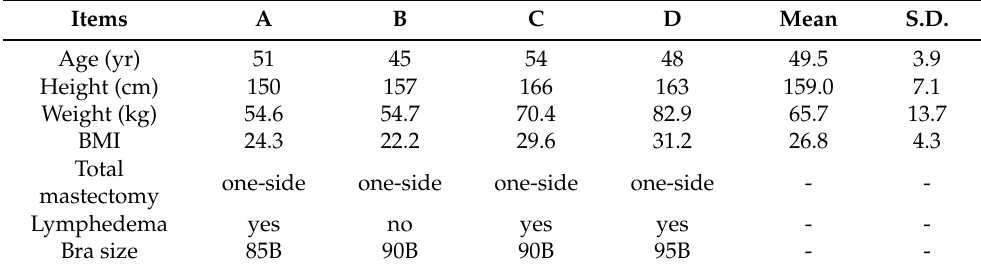
Table 5. Body measurements of participants.